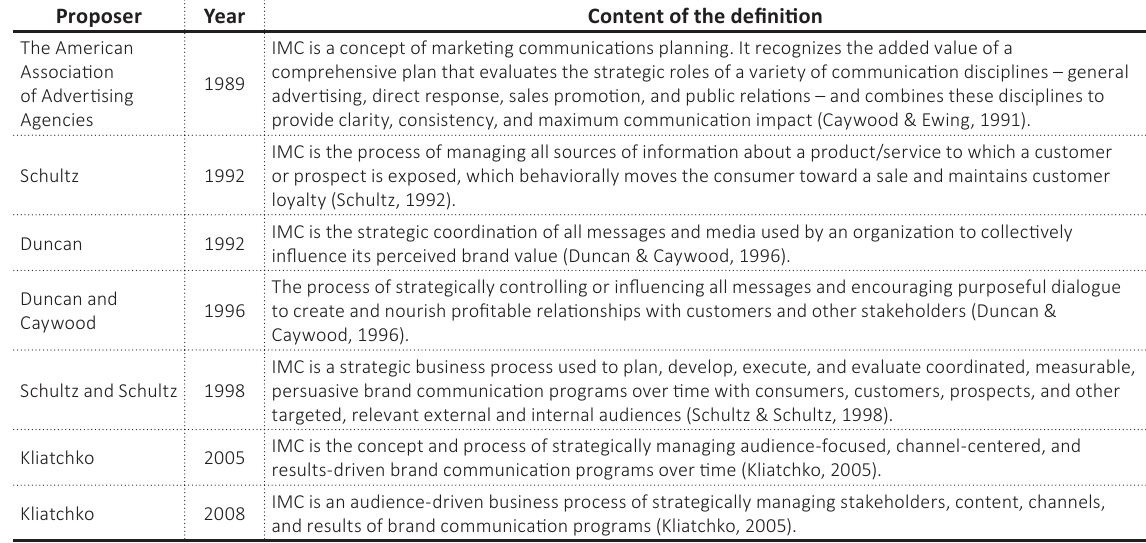
Table 1. Definitions of IMC in different